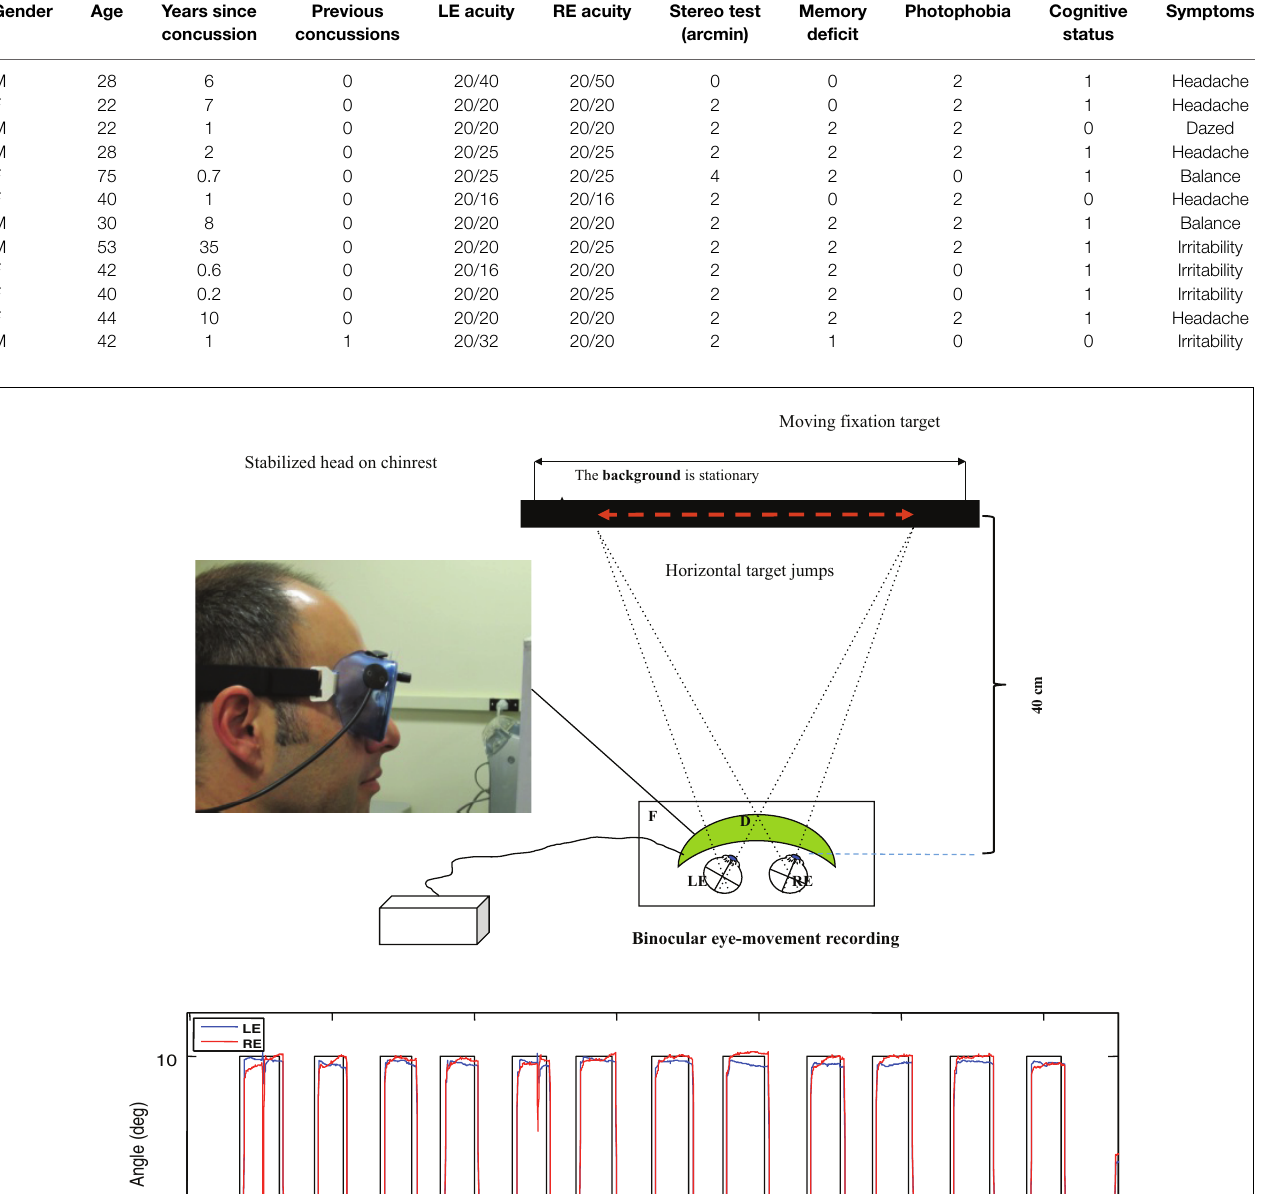
saccades with our head-mounted infra-red recording system. Black line – target position for a series of target jumps separated by randomized delays of 2–3s. Blue line – right eye (RE) trace. Red line – left eye (LE) trace.